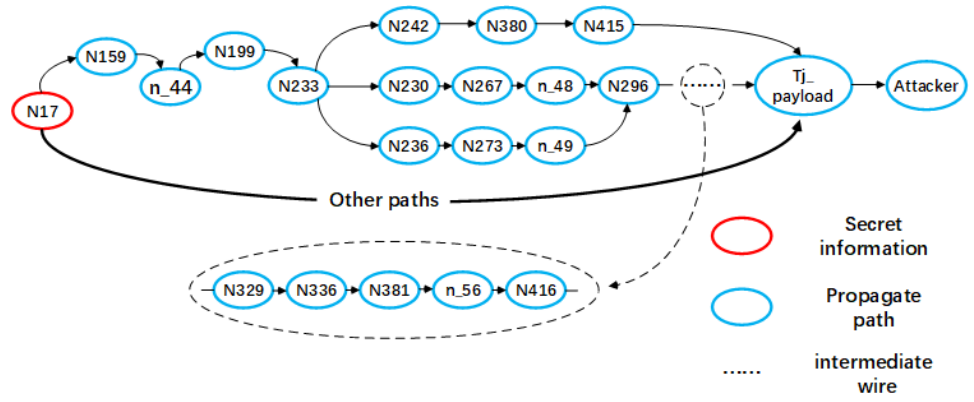
Figure 9. Detected leakage paths of benchmark